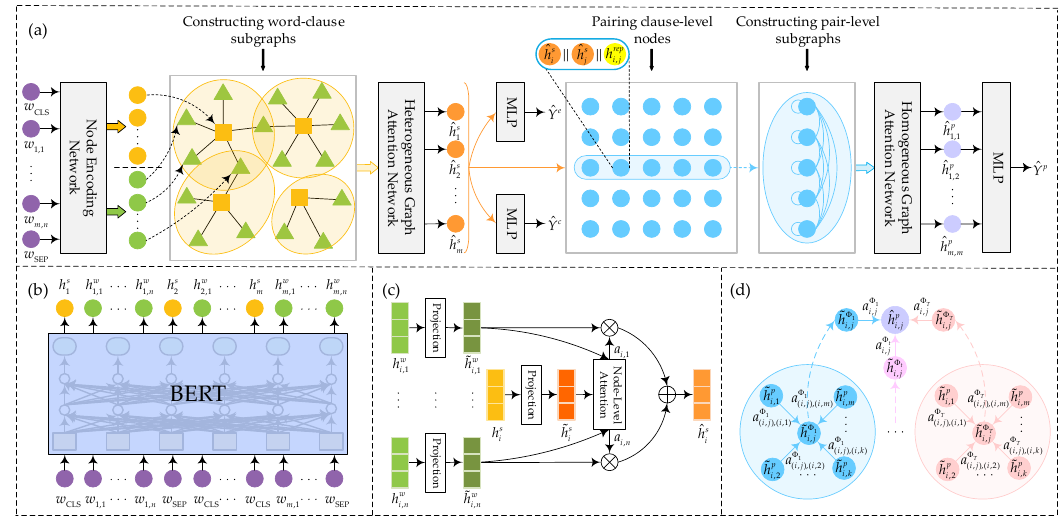
Figure 2. ( a ) An overview of HHGAT; ( b ) node initialization layer; ( c ) clause node encoding layer; ( d ) pair node encoding layer. = pw c represents a node set that consists of three types of nodes, and stands for the edges between all nodes. indicate the sets of words, clauses, and pair nodes, respectively. As shown in Figure 2, a word-to-clause edge distinctly indicates which clause a word is contained in. The two clause nodes connected with the same pair node together form a candidate emotion-cause pair. Moreover, the association between two pair nodes is represented by a pair-to-pair edge.